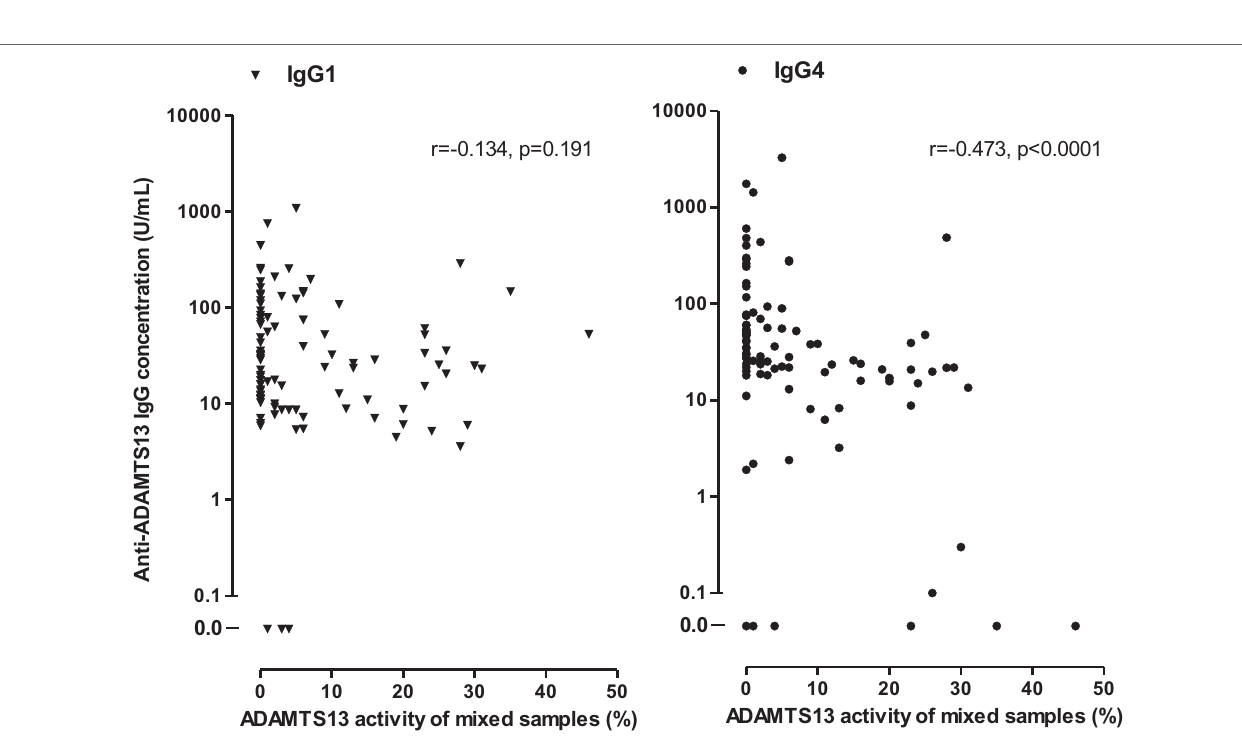
FigUre 5 | Associations of anti-ADAMTS13 IgG1 and IgG4 levels with the ADAMTS13 activity measured in 97 of the 100 deficient patient samples following mixing and incubation with equal amounts (1:1 ratio) of pooled normal human plasma or serum.